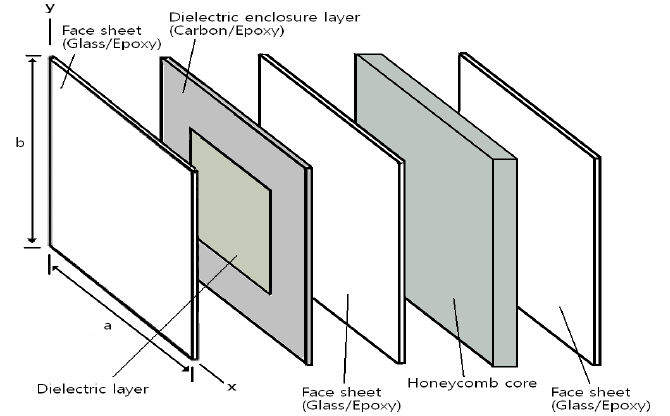
Figure 1. The model of smart-skin antenna